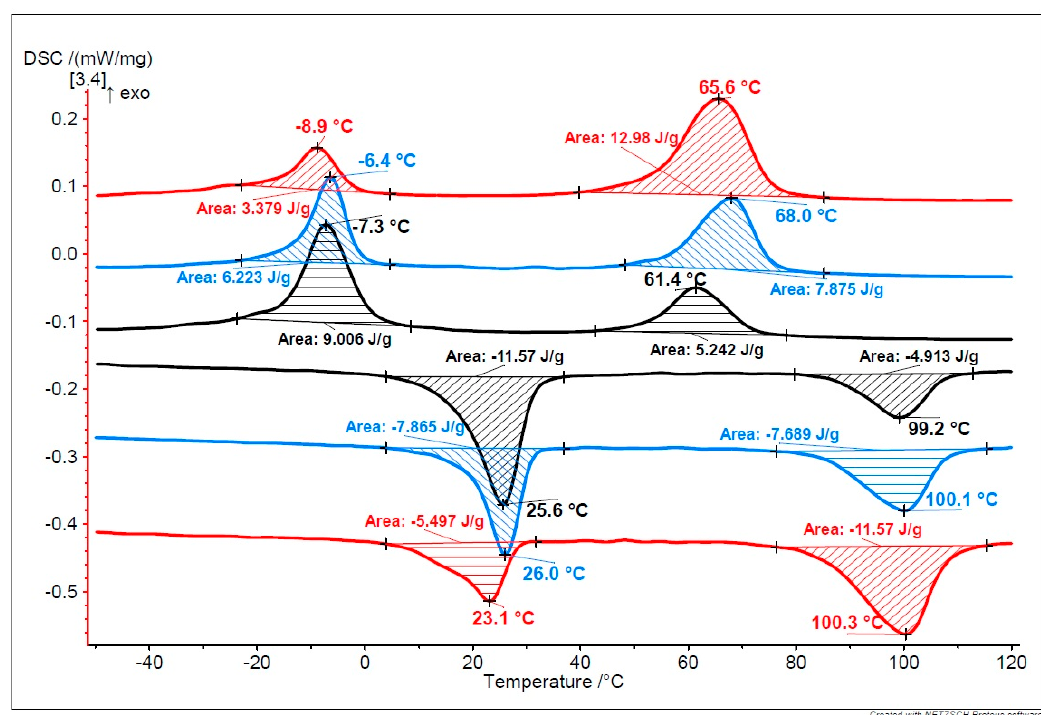
Figure 5. DSC curves of the 4 (black), 16 (blue) and 32 (red) layered Ni 50.3 Ti/Ni 49.6 Ti composites after HSHPT.